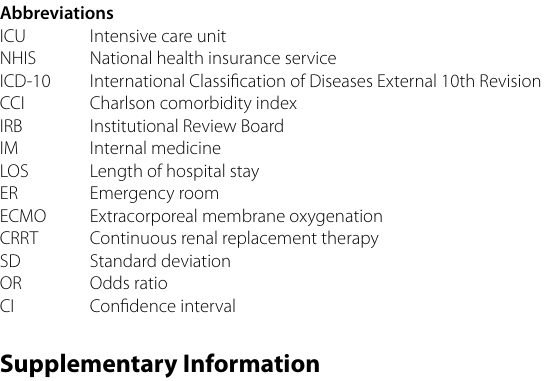
Additional file 2: Table S2 . Clinicopathological characteristics of all patients (n 1,147,493). =